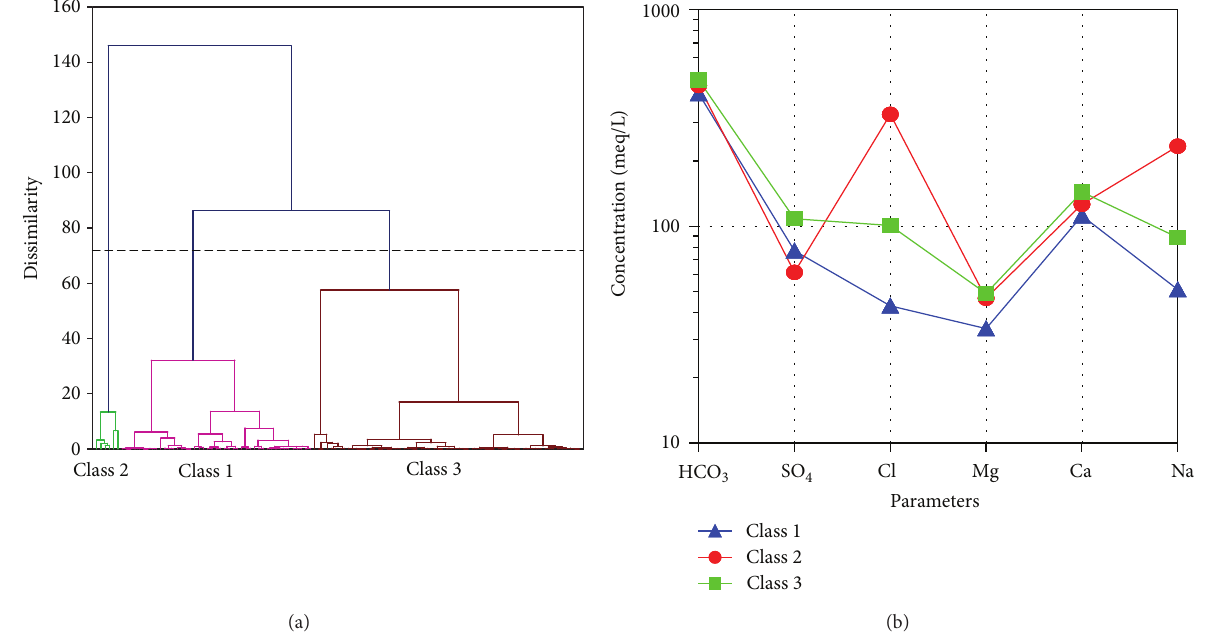
Figure 3: (a) Dendogram of the cluster analysis; (b) Schoeller diagram of the threea groundwater